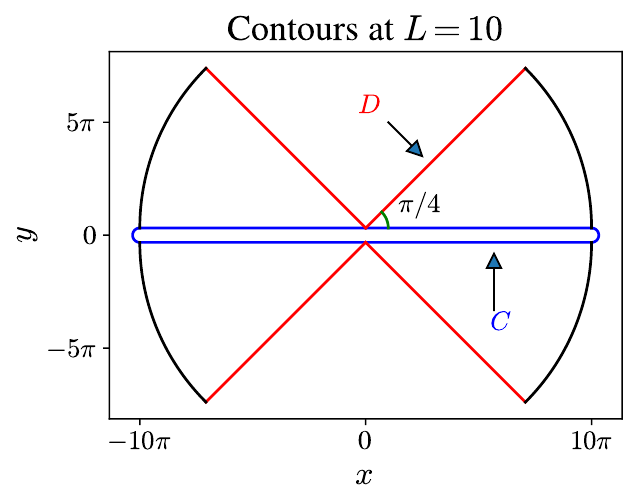
Figure 4: (Color online) Contours of integration. The blue contour C corresponds to Eq. 8. One can deform the contour C to D (the red lines), since the integrand on the arc (the black line) is exponentially small and the function ln f ( z ) is holomorphic when Re ( z ) (cid:54) = 0 and Im ( z ) (cid:54) =